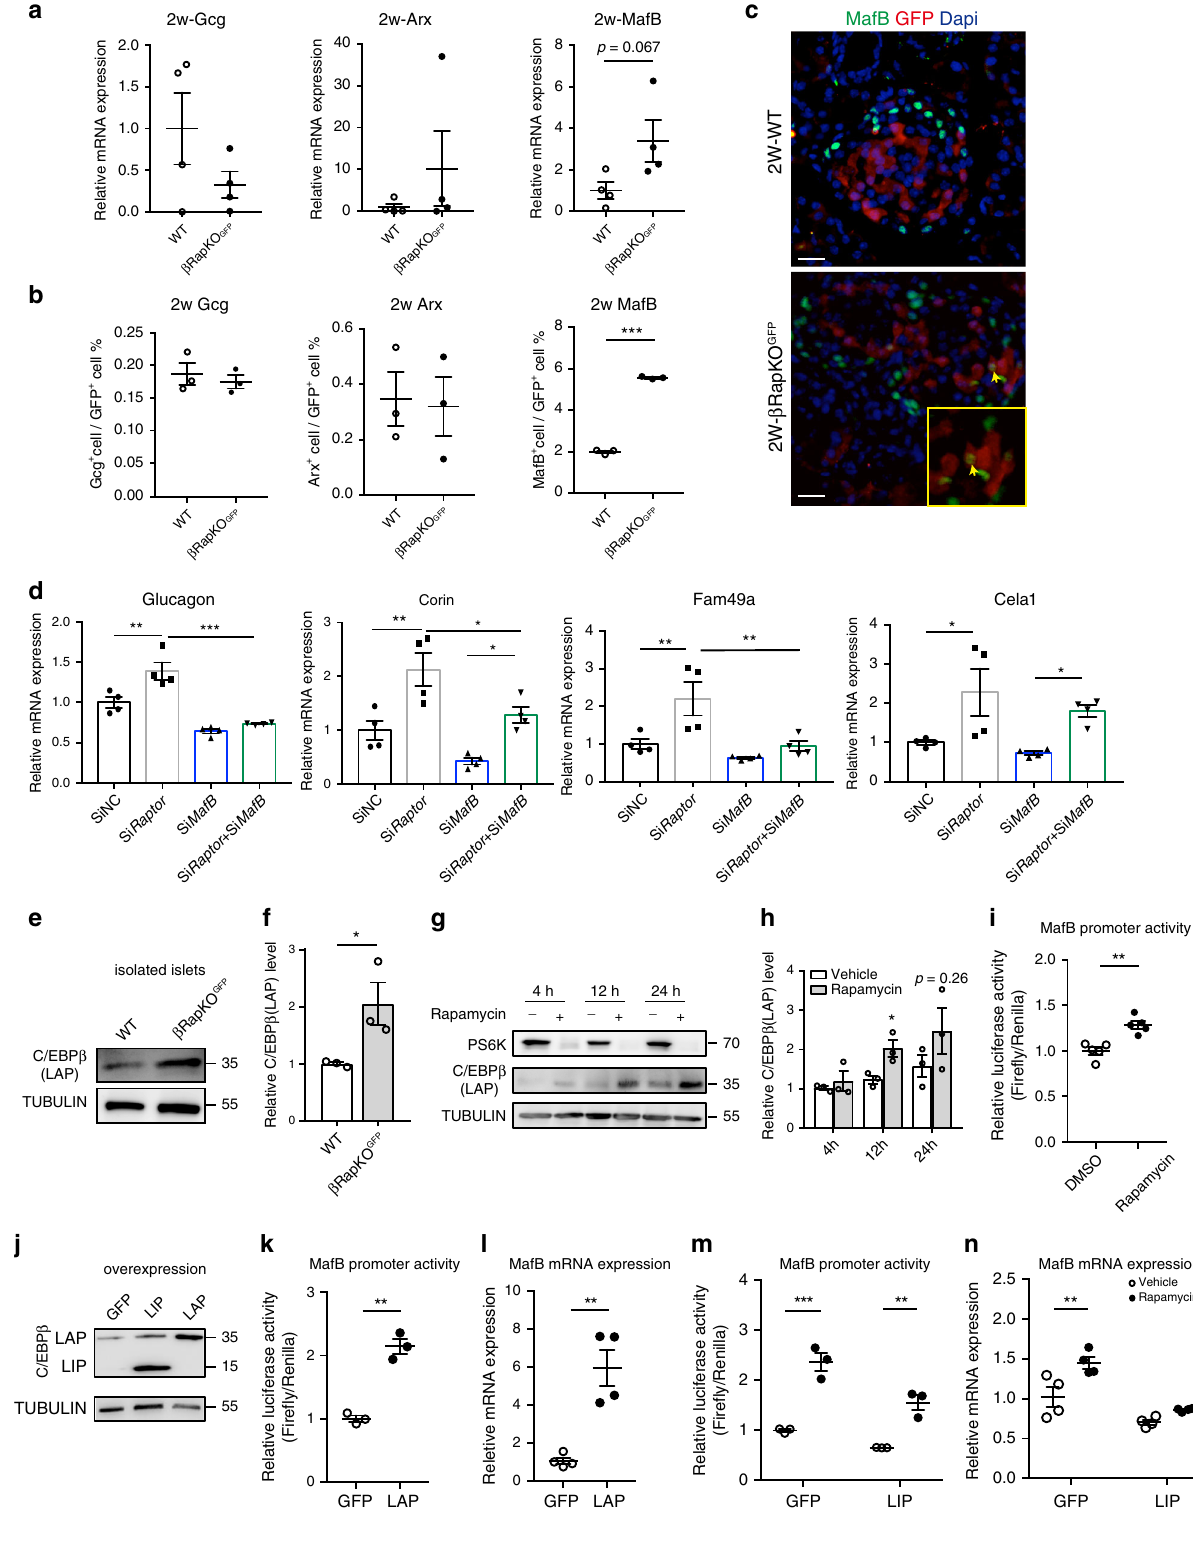
Methods Mice and supplementation with insulin using osmotic pumps . β -Cell-speci fi c Raptor knockout mice ( β RapKO) were generated by crossing Raptor fl ox/ fl ox mice (purchased from the Jackson Laboratory, C57BL/6J) with mice expressing Cre recombinase driven by the rat insulin promoter (RIP-Cre, mixed C57BL/ 6J:129/SvJ) and were further bred to Rosa26-EGFP mice (purchased from the Jackson Laboratory, USA) to generate β RapKO GFP mice ( Raptor − / − , RIP-Cre ,